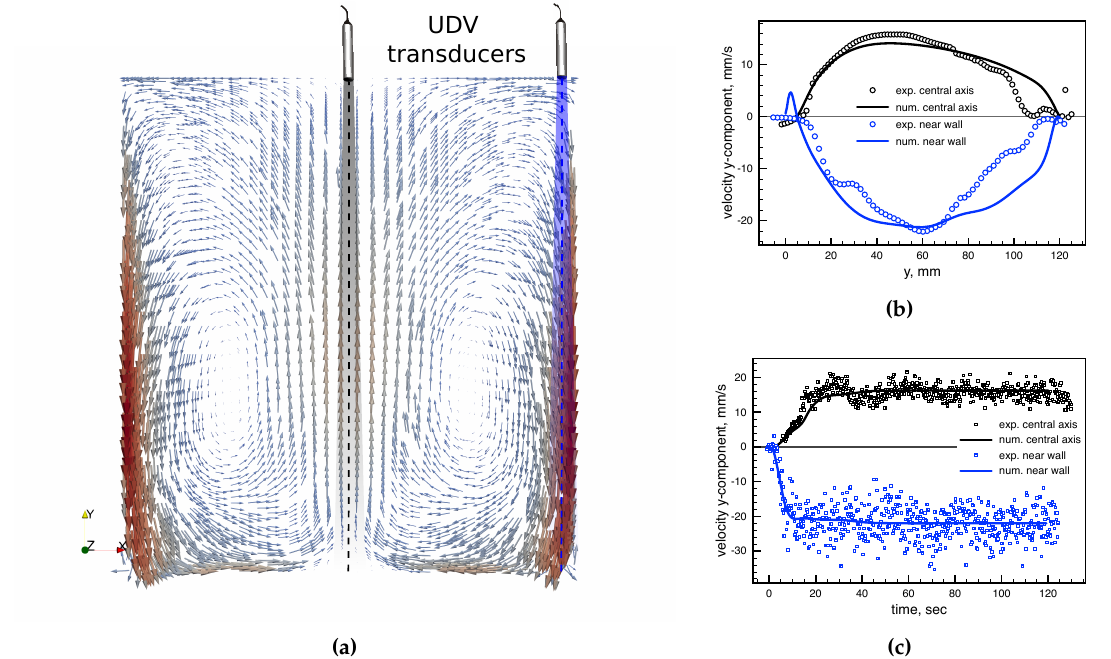
Figure 6. ( a )—velocity field of liquid metal under TMF impact with ultrasound Doppler velocimetry (UDV) transducers placement. ( b )—mean velocity profile, ( c )—velocity dynamics in points at the melt height of 45 mm. Blue color corresponds to near the wall area, black—central axis, whereas dots are experimental data and lines—numerical